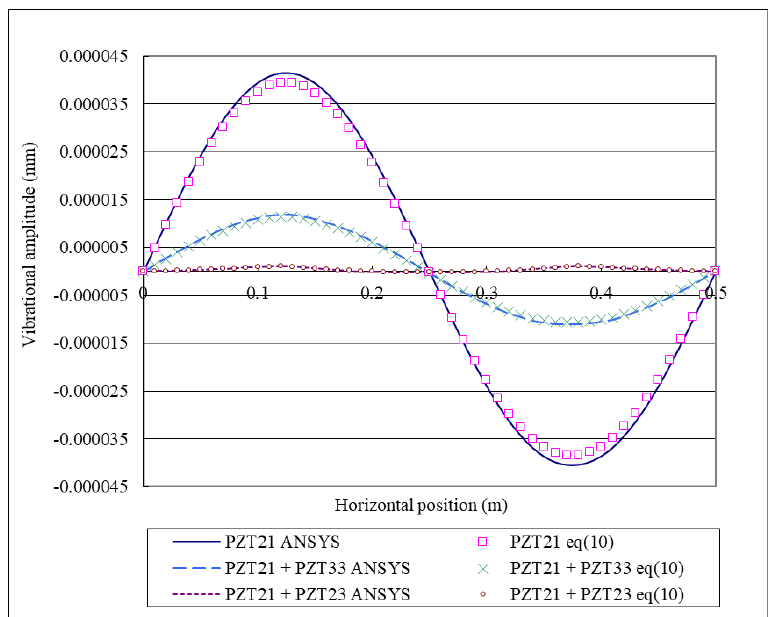
Figure 14. Vibrational amplitudes along the horizontal line (y = 0.25 m) of the composite laminate plate excited by the PZT 21, PZT 21 + PZT 23, and PZT 21 + PZT 33 actuators.